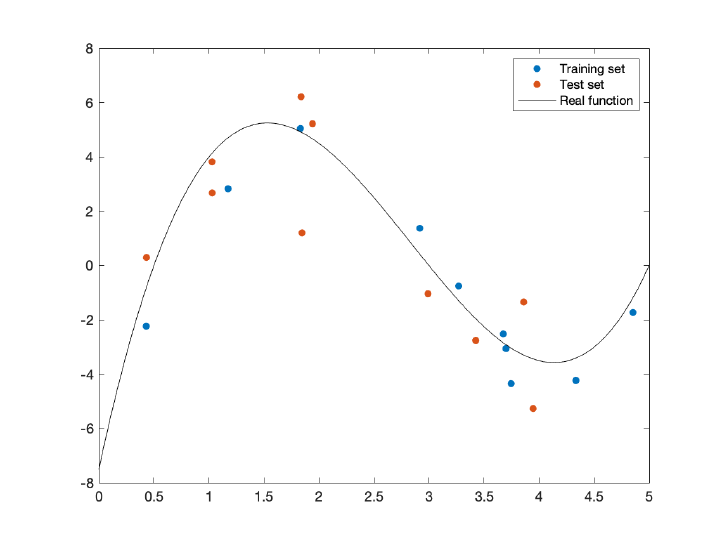
Figure 2. Plot of a training and test dataset. The black curve shows the function used to generate the data.